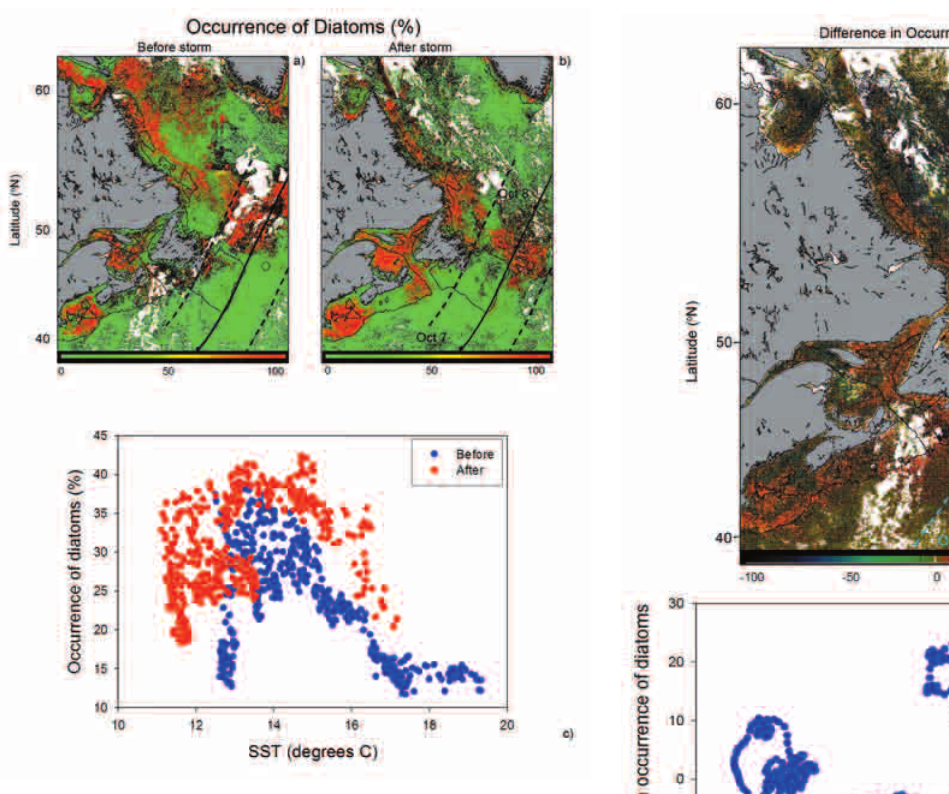
Fig. 14. – Composites of probability to find diatom dominant pop- ulations: a) 12 days before the storm passage, and b) 14 days after the hurricane passage. c) Scatter plot of SST against probability to find diatoms. The data are extracted from the composite images under the 700 km area, and averaged across the storm track.